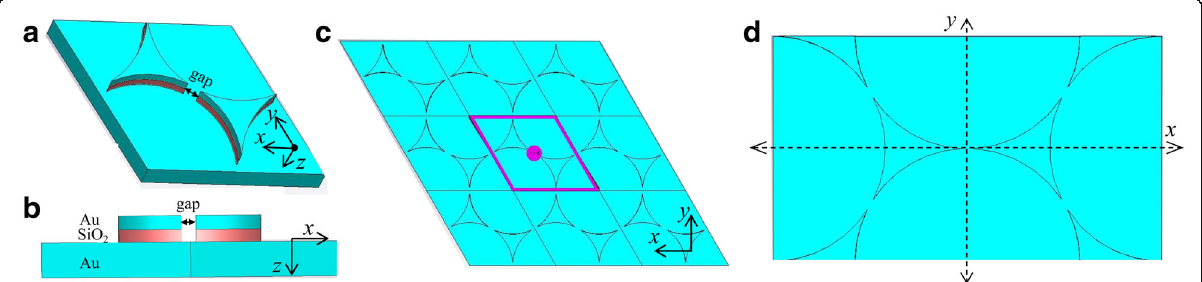
Fig. 1 Schematic of MIM structure sensor. a Perspective view. b Cross-sectional view. c , d Top